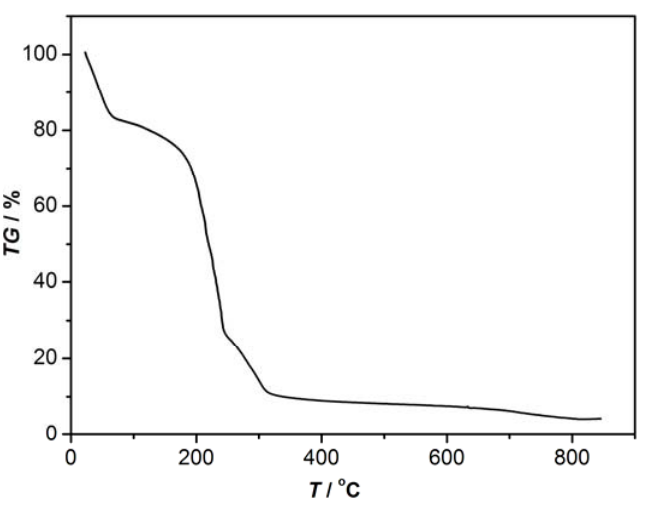
Figure 6. The TG-DTG curve of complex 1.